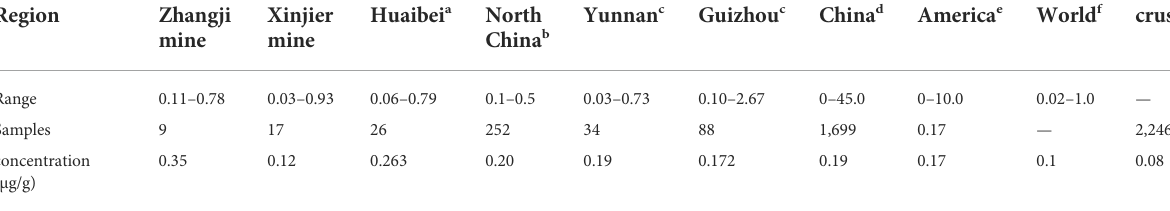
TABLE 2 The average mercury concentration of Huainan Coal fi eld Shanxi Formation and other country/region coals ( μ g/g).